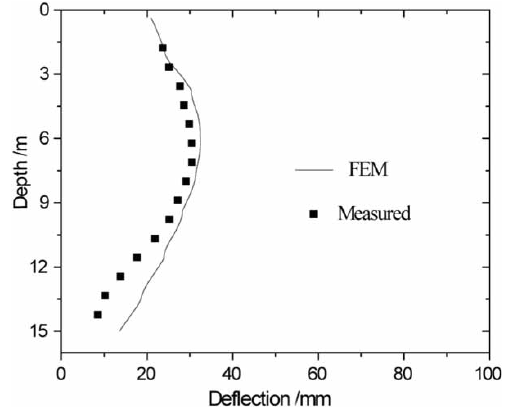
Fig. 6. Comparison of measured and calculated inner wall